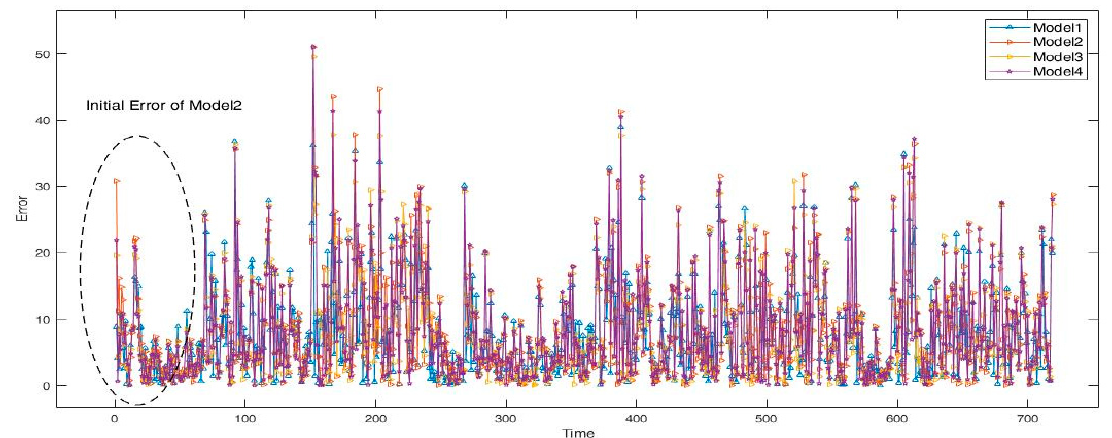
Figure 8. Comparison of predictive errors for each model in C region of Jeju Island.